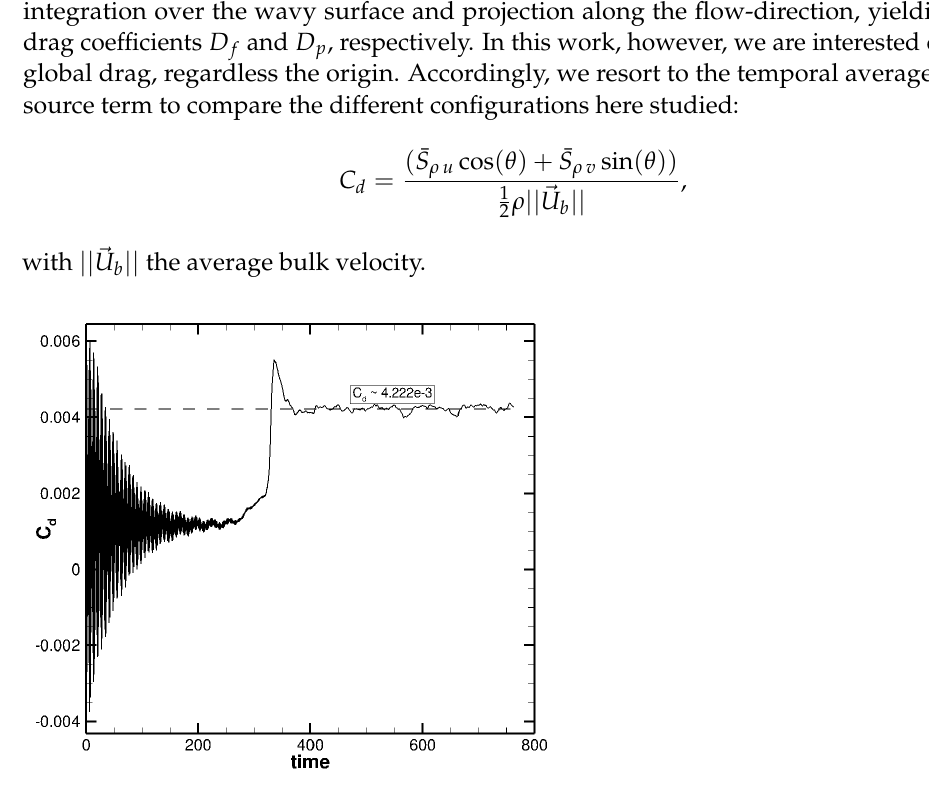
Figure 2. Wavy wall channel flow at Re = 2820: evolution of C d (Equation (2)). Observe that during the initial steps of the simulation the average momentum is far from the prescribed ( cos ( θ ) ,sin ( θ )) , and taking into account that the source term is divided by ∆ t , (Equation (1)), this produces unphysical strong oscillations of the